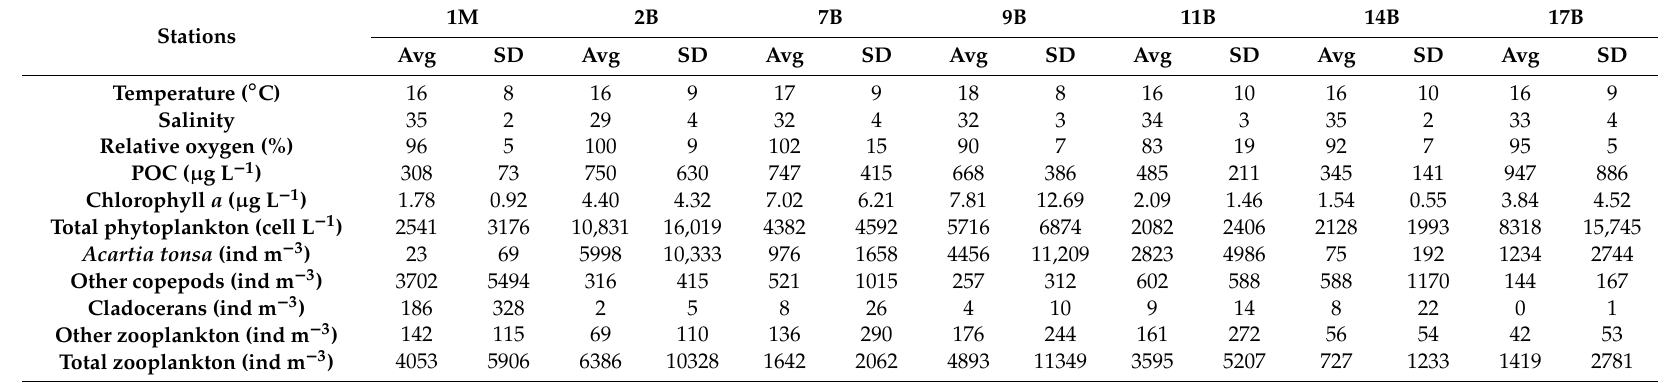
Table 2. Average and standard deviation values of the hydro-chemical data and biological concentrations (phytoplankton, A. tonsa , and main mesozooplankton groups) at the seven stations for the 2003–2004